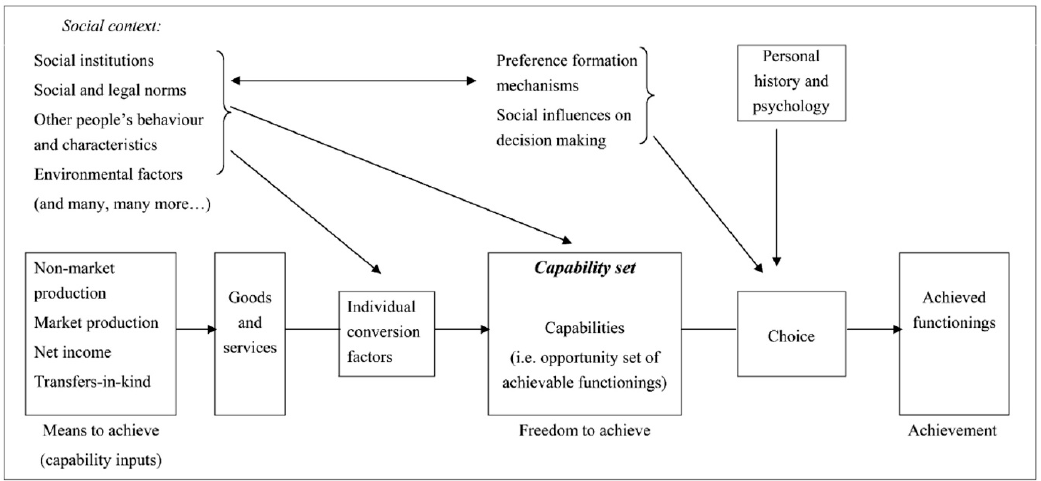
Figure 1. A stylized non-dynamic representation of a person’s capability set and her social personal context [15]